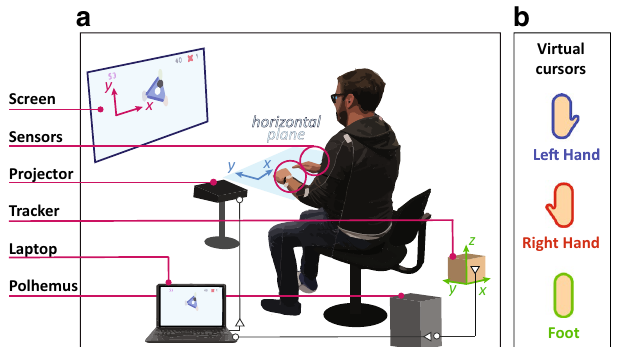
Figure 1. ( a ) Experimental setup: the hands and foot movements are tracked using the Polhemus Liberty tracking system. ( b ) Virtual